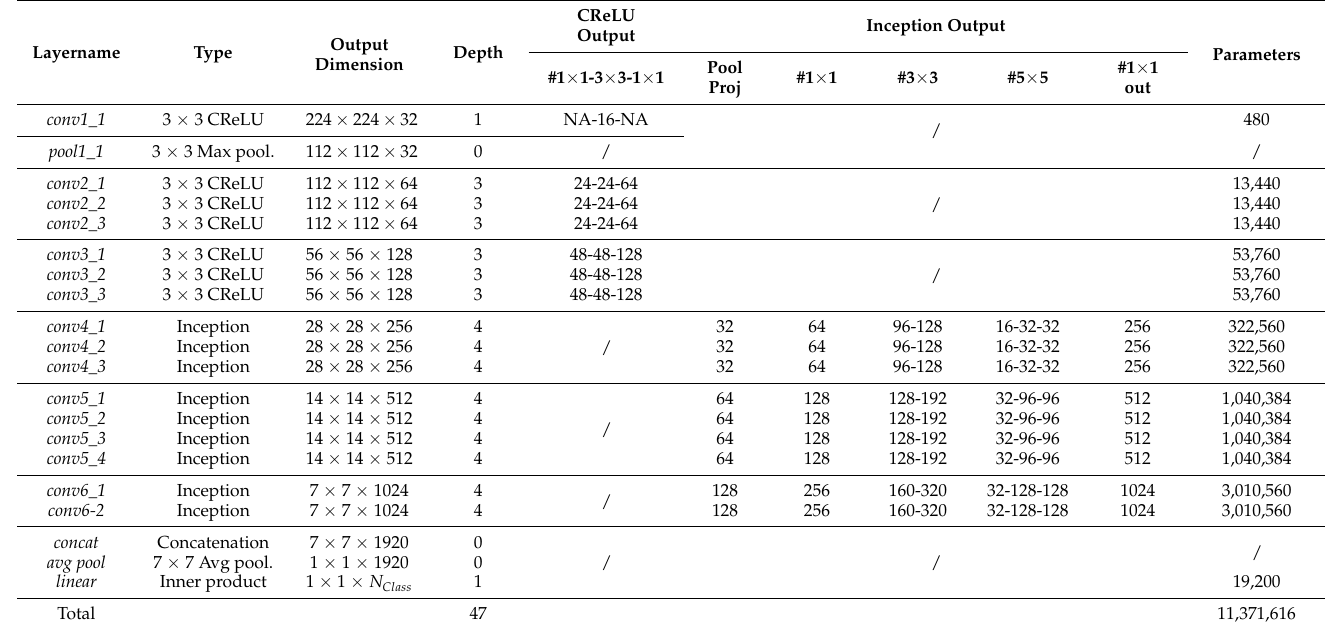
Table 4. The parameters of